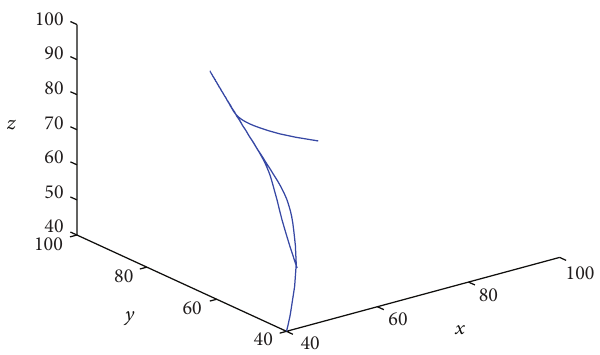
Figure 4: Plot of global stability of 𝑃 3 (𝑥 ∗ , 𝑦 ∗ ,𝑧 ∗ ) .